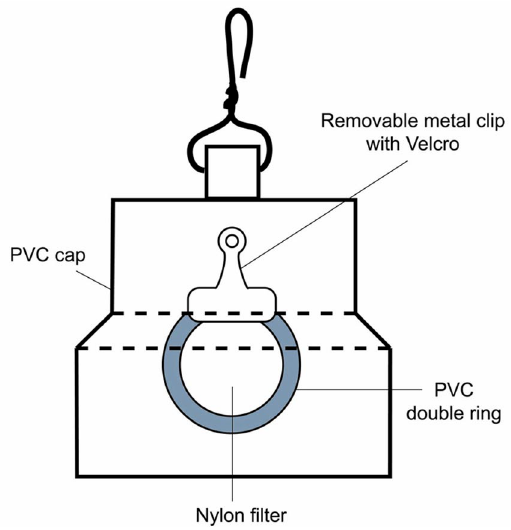
FIGURE 3. Changes of seasonal average HNO 3 concentrations measured with honeycomb denuder/filter pack systems and passive samplers along the Kaweah/Marble Fork drainage in Sequoia National Park in summer 1999.